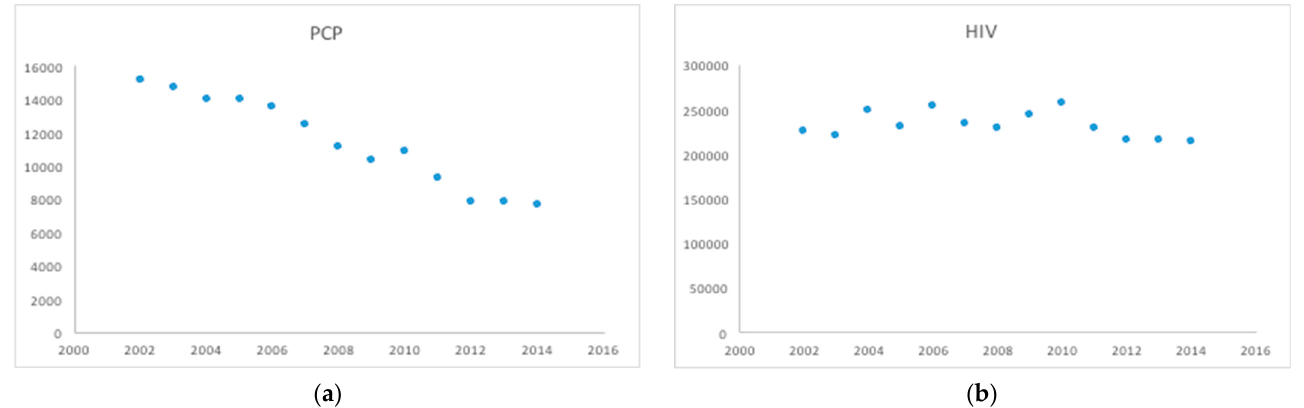
Figure 1. Trends of hospitalization Pneumocystis pneumonia in HIV ( a ) and HIV admissions in general ( b ) 2002–2014.